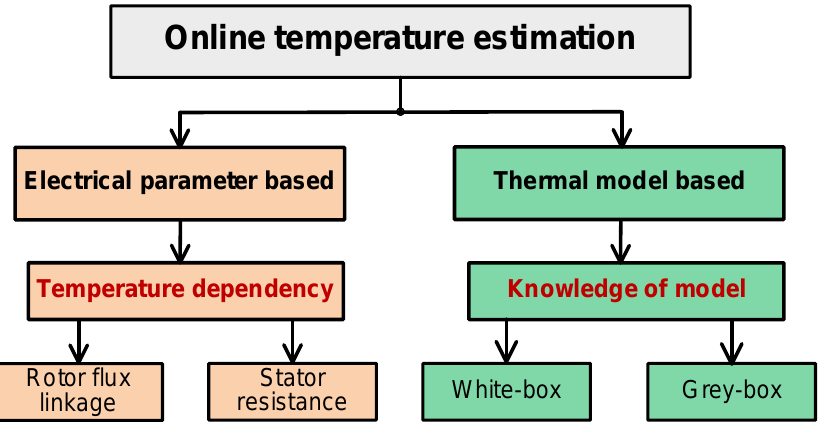
Figure 32. Overview of online temperature estimation methods.